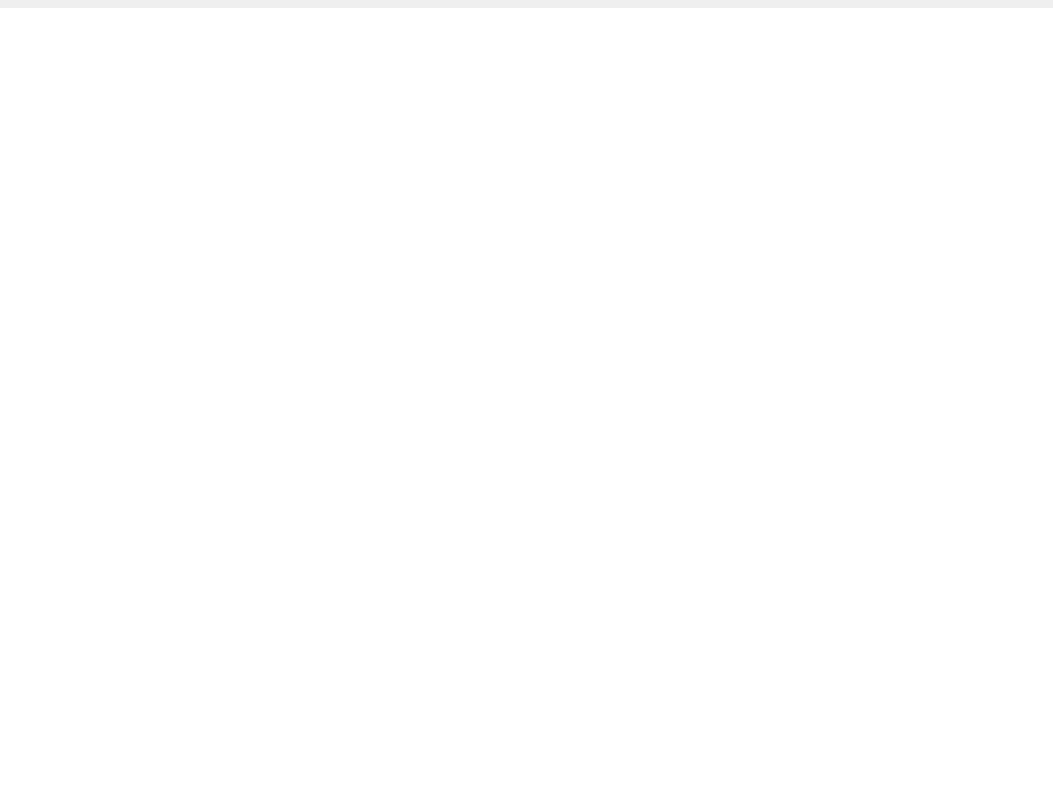
Figure 2 Management protocol of nontraumatic hip pain. ER = emergency room; TSH = transient synovitis of the